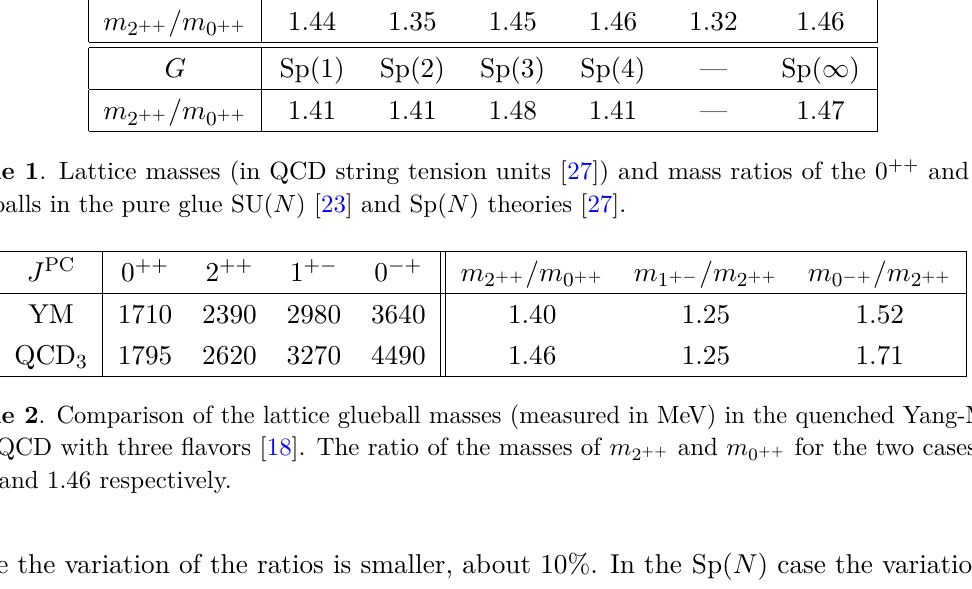
and m for the two cases are 2 ++ 0 ++